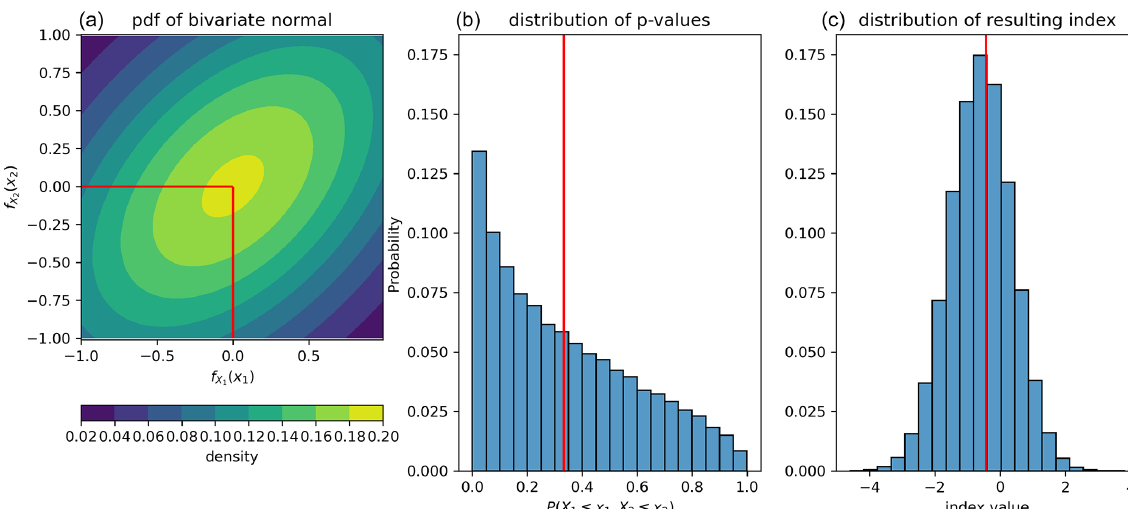
Figure 2. Bi-variate example of a probabilistic multivariate index as in Hao and AghaKouchak (2013) and Guo et al. (2019) without scaling of p where X 1 ,X 2 ∼ N( 0 , 1 ) and the covariance between them is 0.5. PDF (a) ; distribution of the CDF of samples from it (b) ; the resulting distribution of the index (c) . The red lines mark an example case where x 1 = x 2 = 0 at different processing steps. Table 1. Overview of VOD datasets used in this study with their temporal coverage, local ascending equatorial crossing times (AECT), whether the ascending (A) or descending (D) overpass is used, and frequencies (GHz) used for each product. The C- and X-band retrievals are based on van der Schalie et al. (2017) and the Ku-band retrievals on Owe et al. (2008). Sensor Time period used AECT Overpass C-band X-band Ku-band AMSR-E Jun 2002–Oct 2011 13:30 D AMSR2